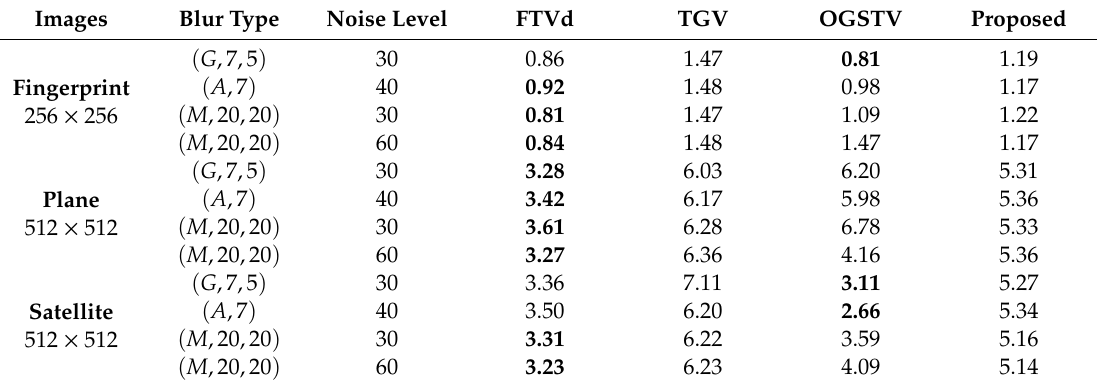
Table 6. Image restoration time (s) of the degraded test images with di ff erent levels of blur and impulse